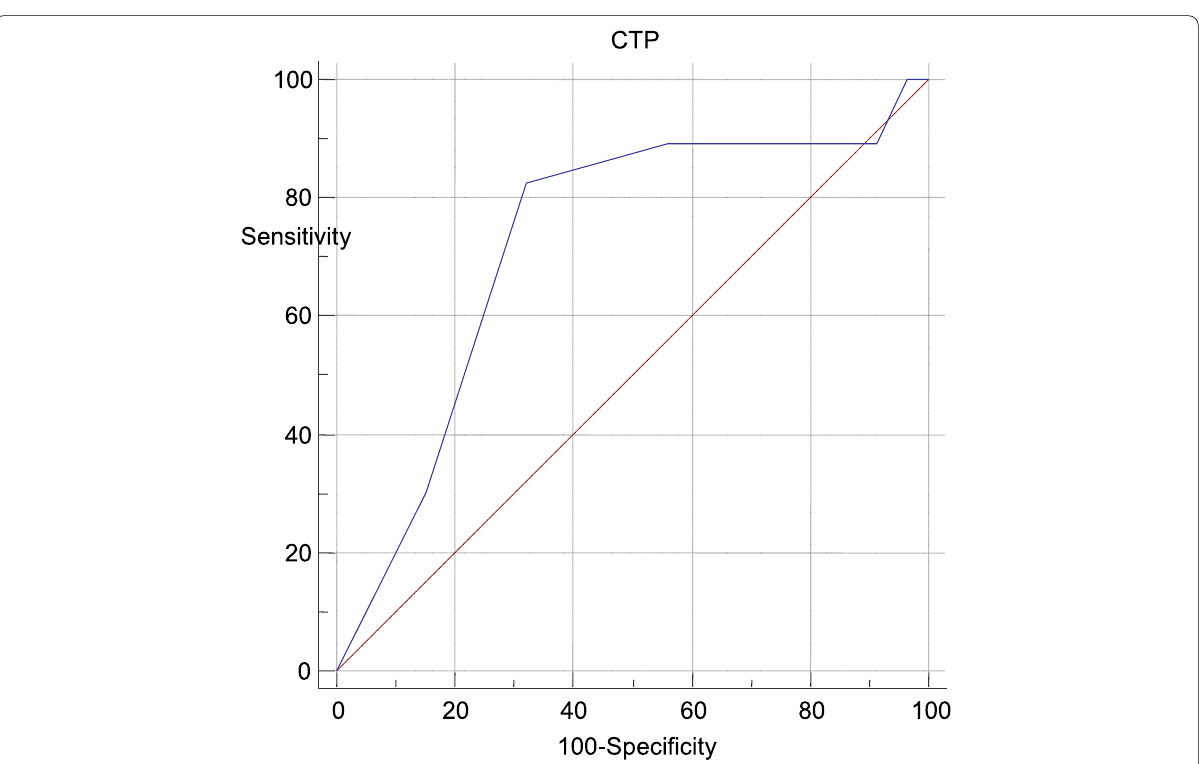
Fig. 2 AUROC for AEC in predicting